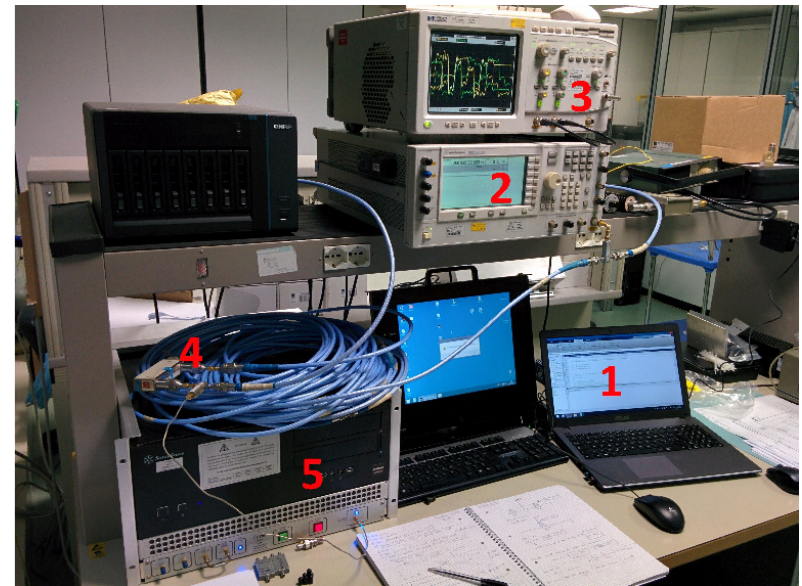
Figure 12. Experimental measure set-up: (1) Offline Stage, (2) radio-frequency (RF) Signal Generator, (3) Oscilloscope, (4) Cables + Variable Attenuator, (5) Signal